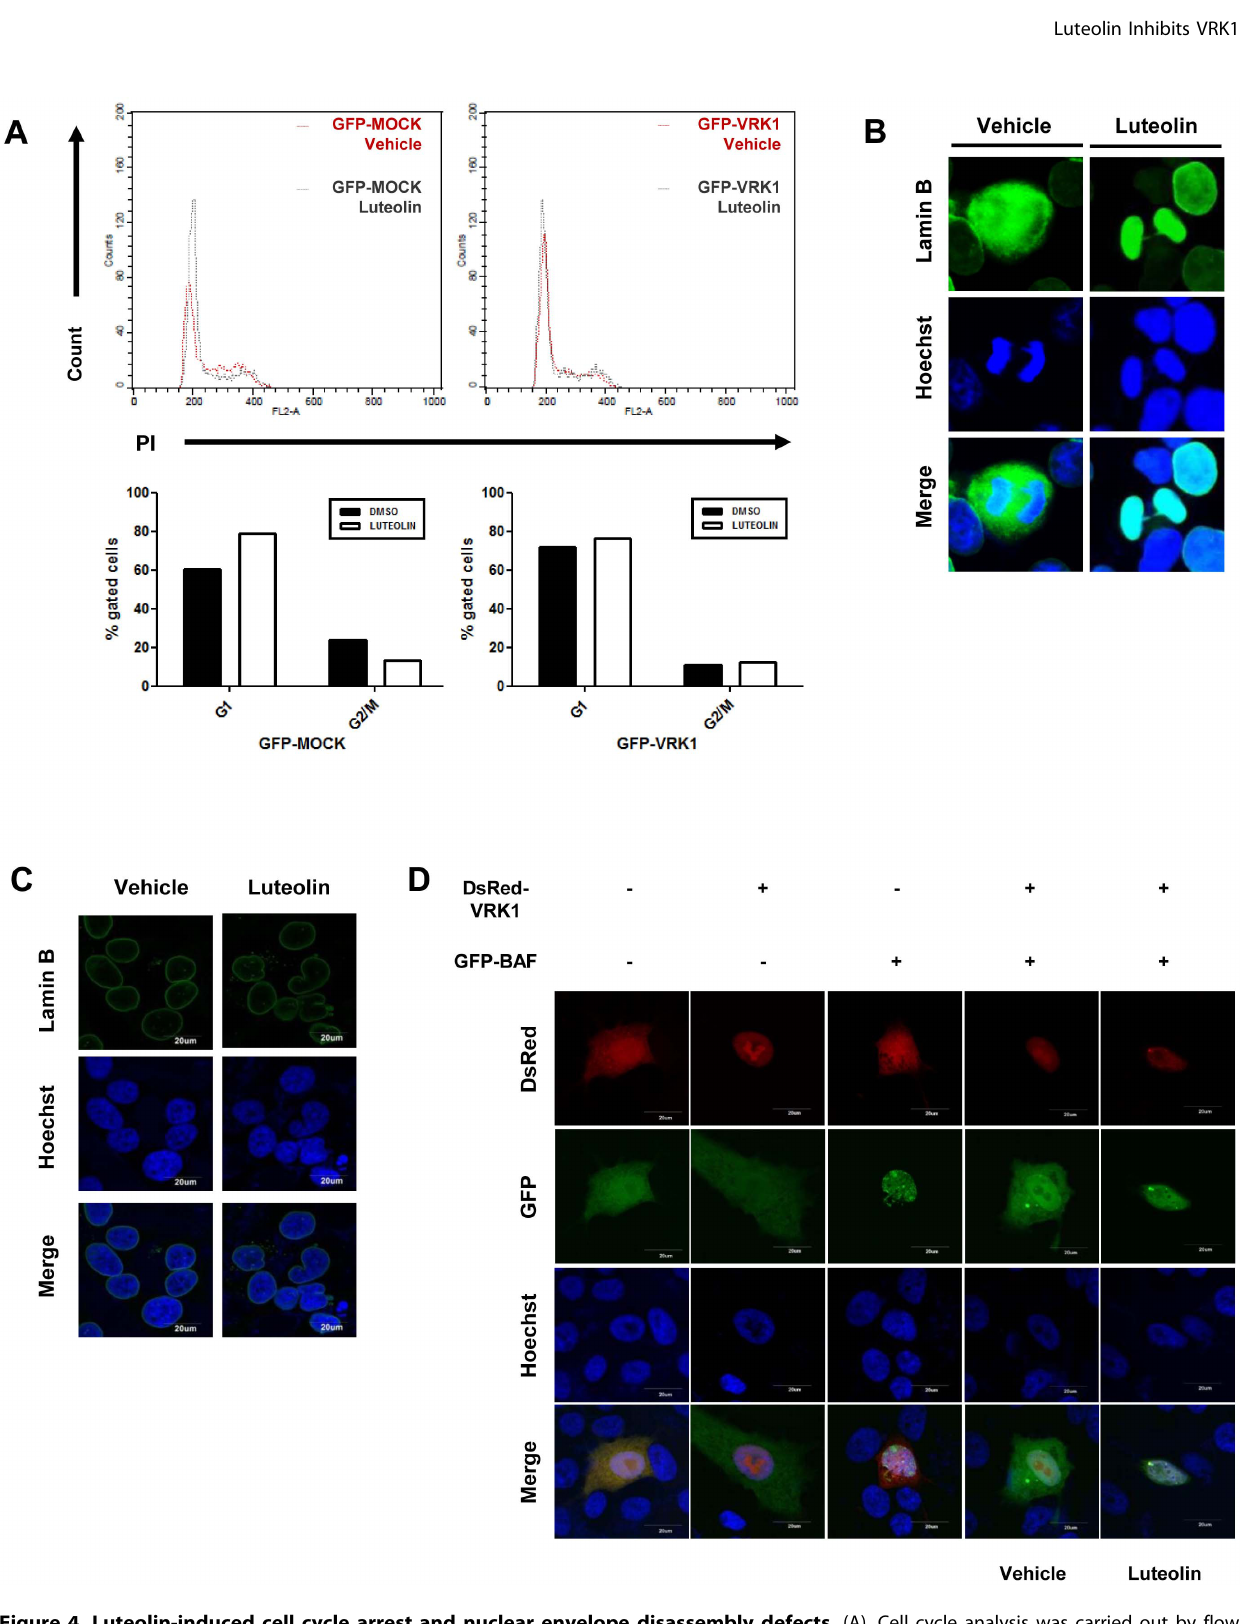
Figure 4. Luteolin-induced cell cycle arrest and nuclear envelope disassembly defects. (A), Cell cycle analysis was carried out by flow cytometry. HeLa cells transfected with GFP or GFP-VRK1 were treated with luteolin for 24 hours, and 10,000 cells were gated for analysis. Quantitative data are below the histogram plots. (B) and (C), HeLa cells treated with vehicle or luteolin were stained with lamin B antibody to visualize nuclear envelope and with Hoechst 33342 to visualized DNA. Alexa 488 dye-conjugated antibody was used as secondary antibody. The slides were visualized by fluorescence microscopy (B), or confocal laser scanning microscopy (C). (D), Fluorescent staining of VRK1, BAF, and DNA for analysis of the phosphorylation-mediated re-localization of BAF. Cells co-transfected with GFP or GFP-BAF with RFP or RFP-VRK1 were treated with DMSO or 10 m M luteolin for 24 hours. doi:10.1371/journal.pone.0109655.g004 PLOS ONE |